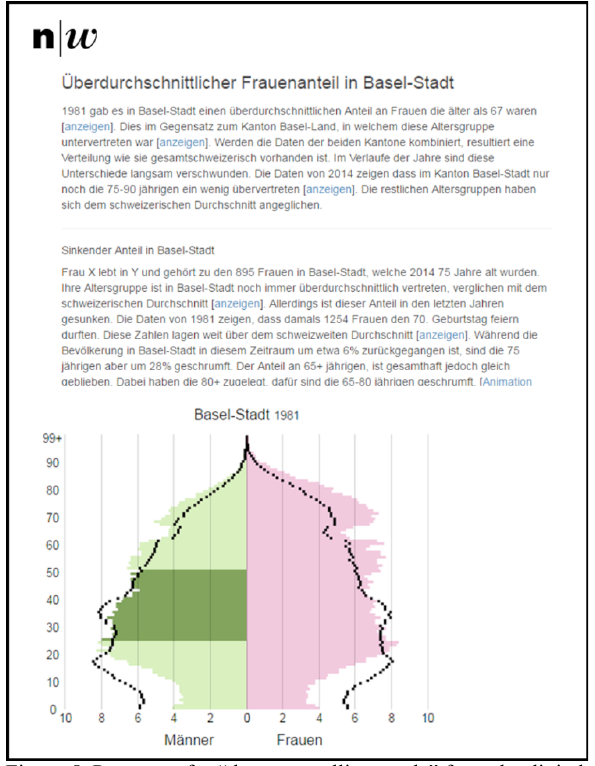
Figure 5. Prototype for “data storytelling mode” from the digital experiments.